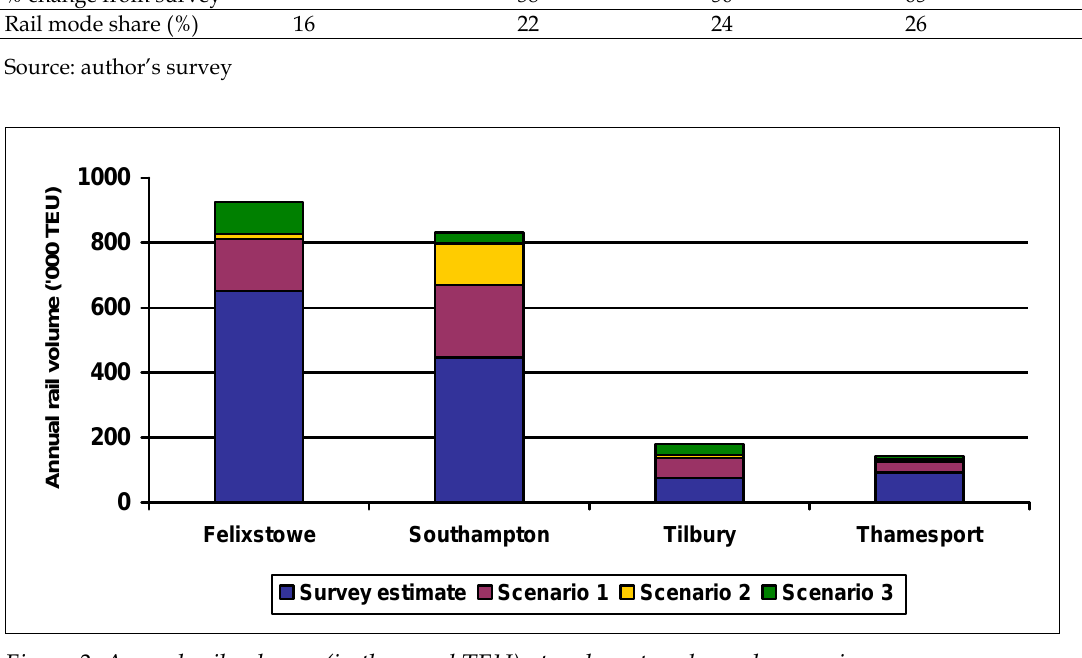
Figure 2. Annual rail volumes (in thousand TEU) at each port under each scenario Source: author’s